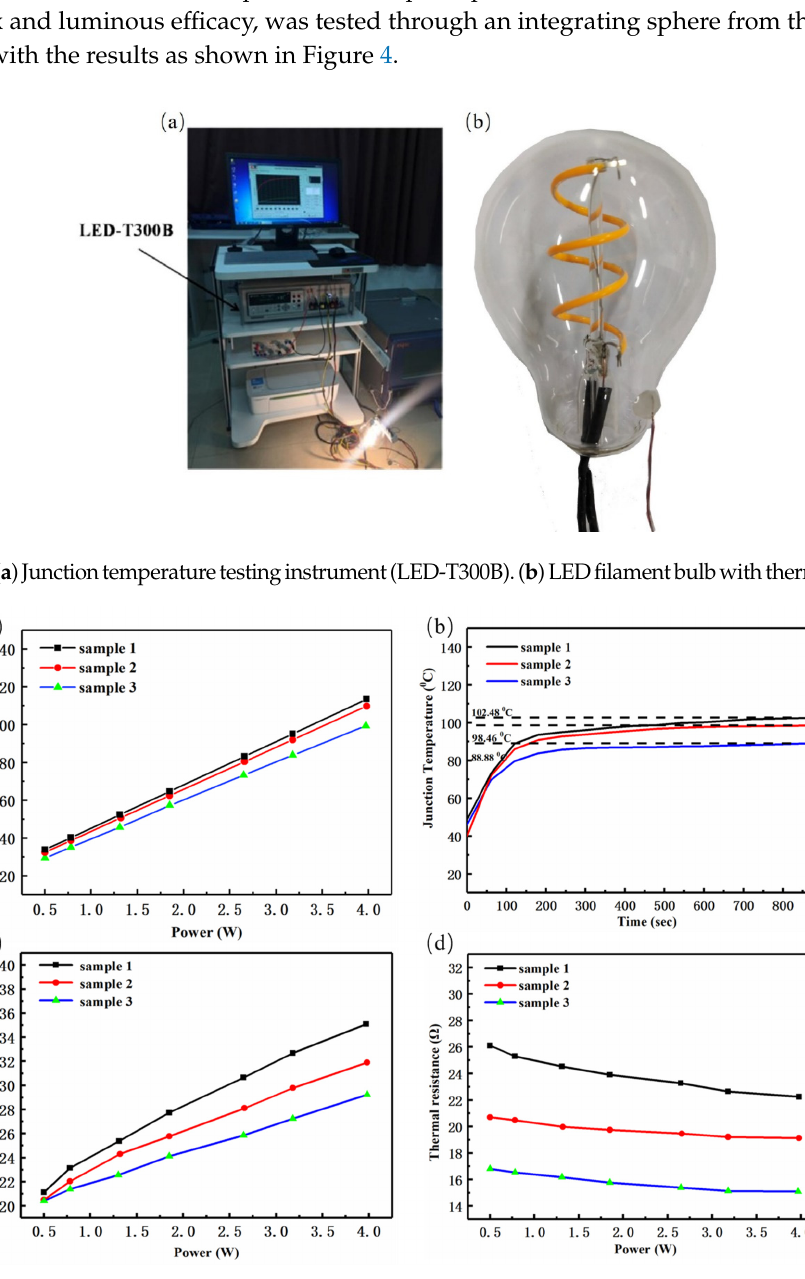
Figure 3. Temperature performances of three di ff erent filament arrangements: ( a ) Junction temperature under di ff erent powers. ( b ) Steady state process of junction temperature at a power of 3.5 W. ( c ) Temperature of surface bulb. ( d ) Thermal resistance.